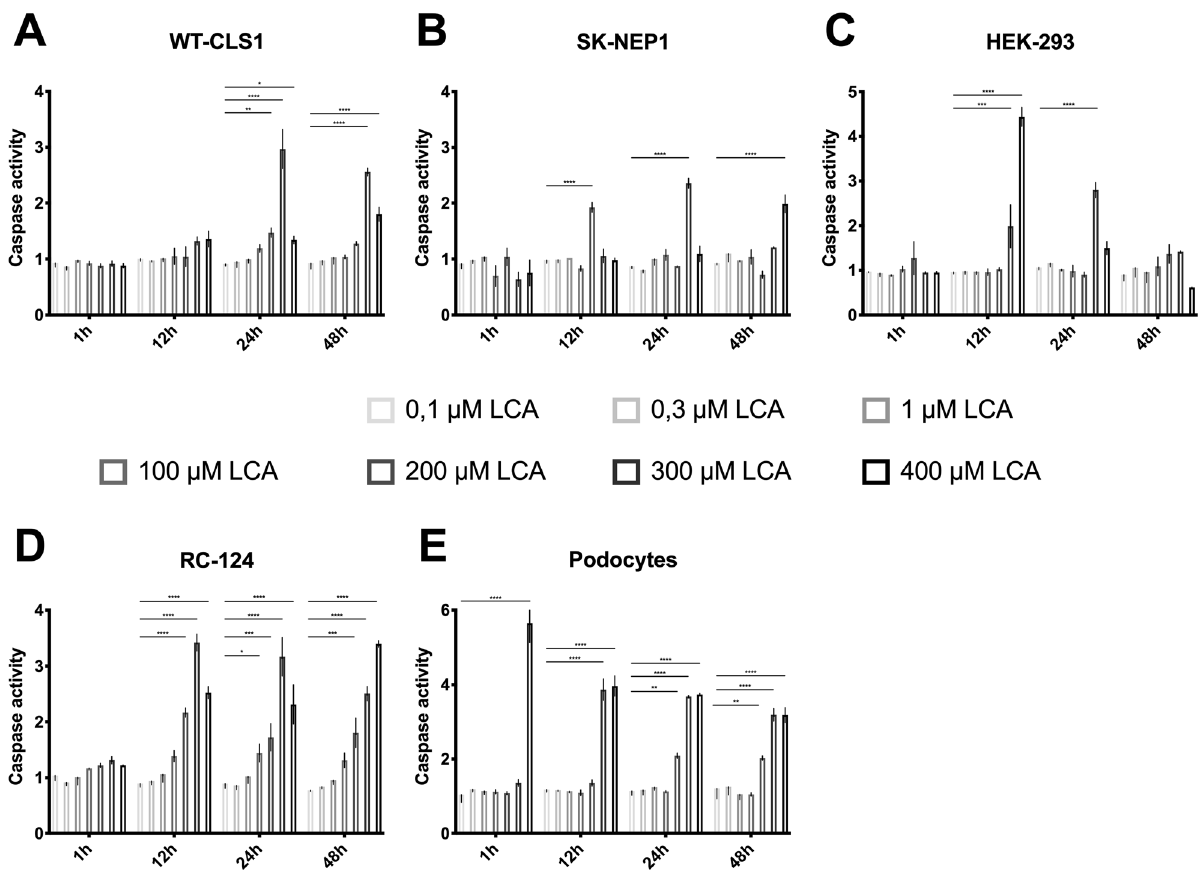
Figure 5. Caspase 3 and 7 activation due to LCA. All cell-lines were treated as described in “Methods” with different doses at different timepoints. Data are presented as mean ± SD of values from three independent experiments. Significance level was set as p < 0.05 (*< 0.05; **< 0.005; ***< 0.0005; ****<